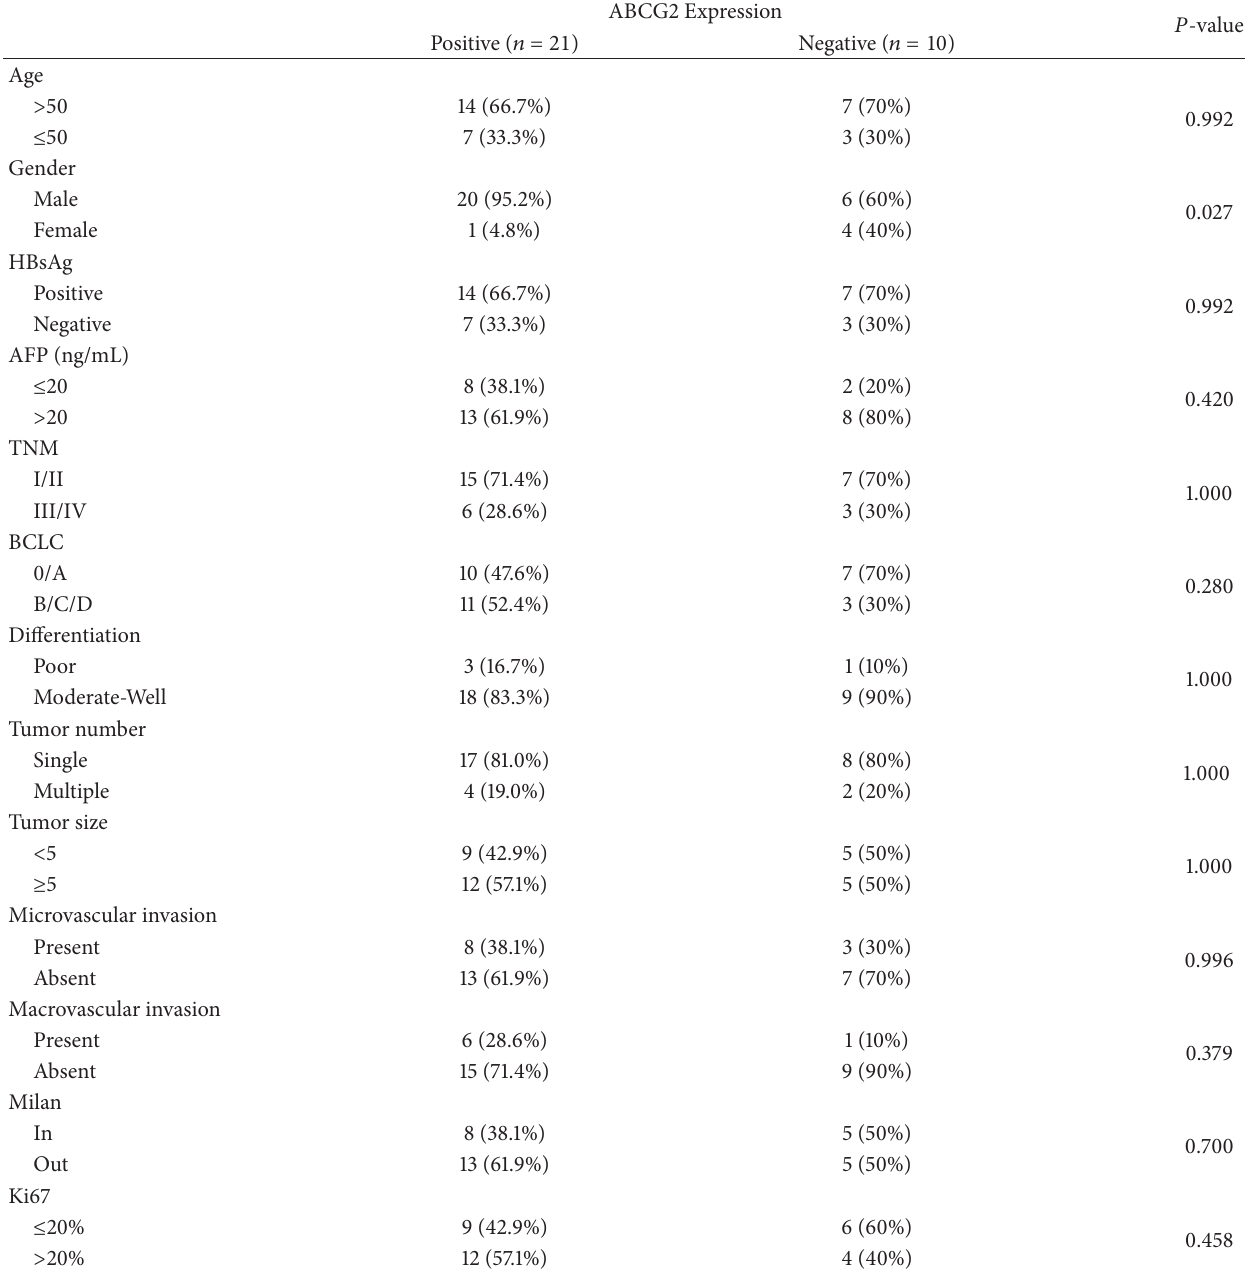
Table 1: ABCG2 expression and characteristics of